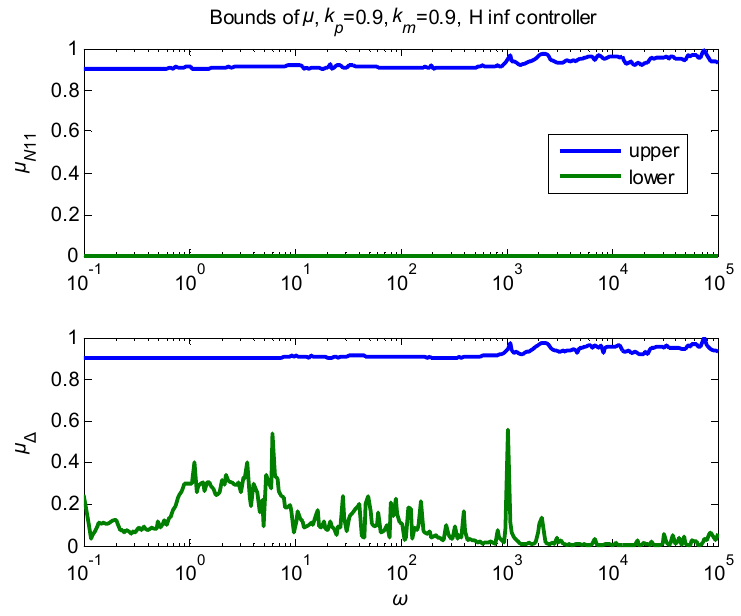
Figure 6. Bounds of the μ value.